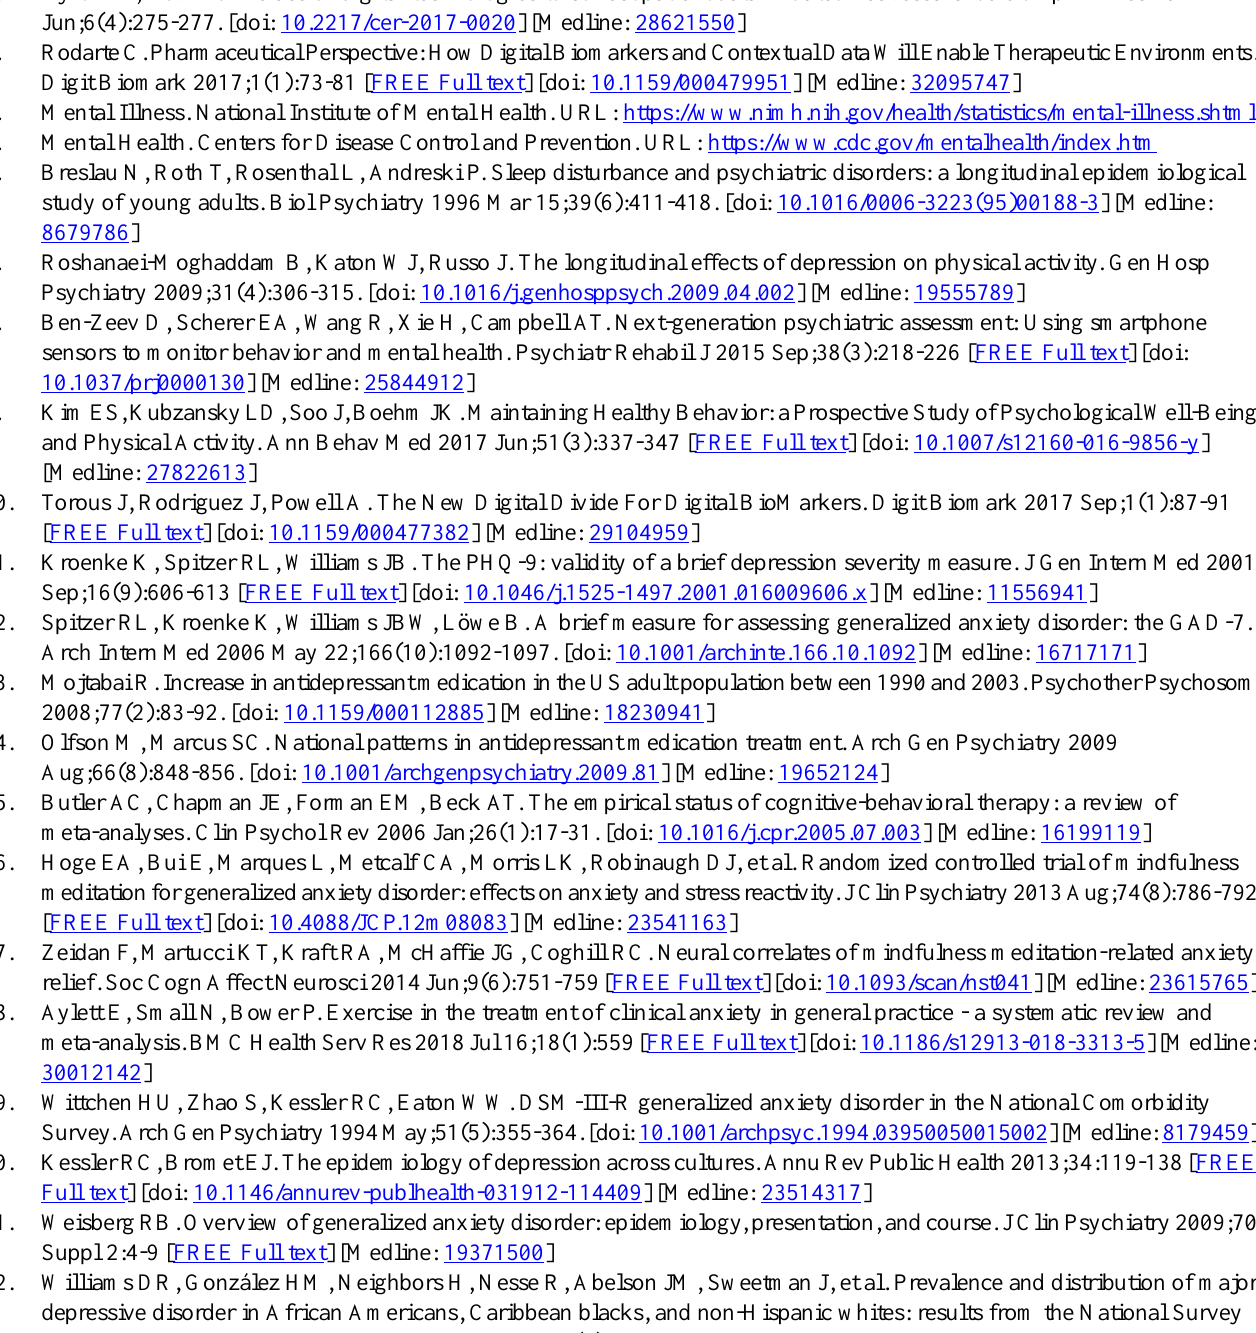
GAD-7: Generalized Anxiety Disorder Questionnaire PHQ-9: Patient Health